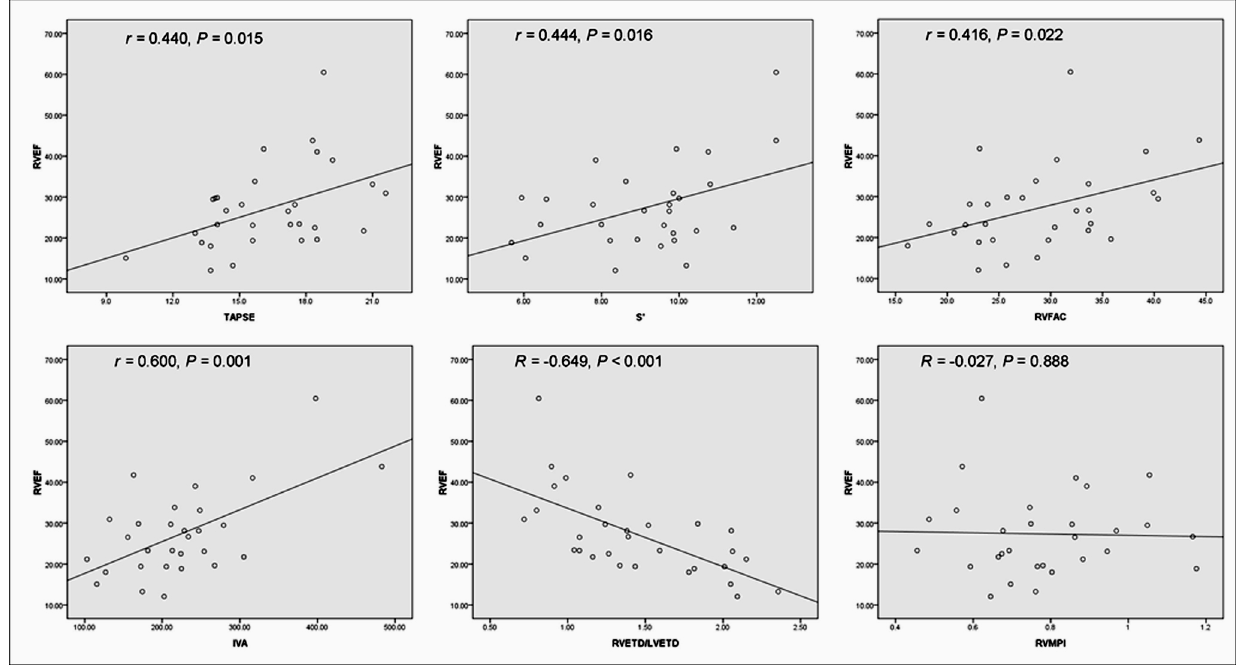
Figure 1. Correlations between echocardiographic parameters and right ventricular ejection fraction TAPSE, tricuspid annual plane systolic excursion; S’, tricuspid annular systolic excursion velocity; IVA, right ventricular isovolumic acceleration; RVFAC, right ventricular fraction area change; RVMPI, right ventricular myocardial performance index; RVETD/LVETD, ratio of right ventricular transverse diameter to left ventricular transverse diameter; RVEF, right ventricular ejection fraction.